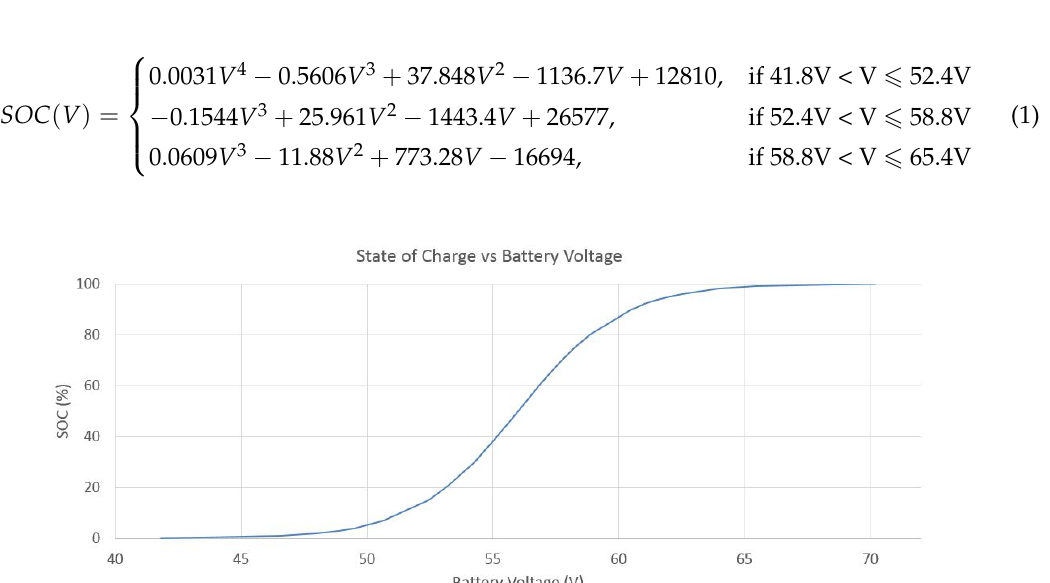
Figure 4. State of charge versus battery voltage. The battery voltage is determined by the voltage of the reference cell multiplied by 40, as the stack is formed by 40 cells in series.